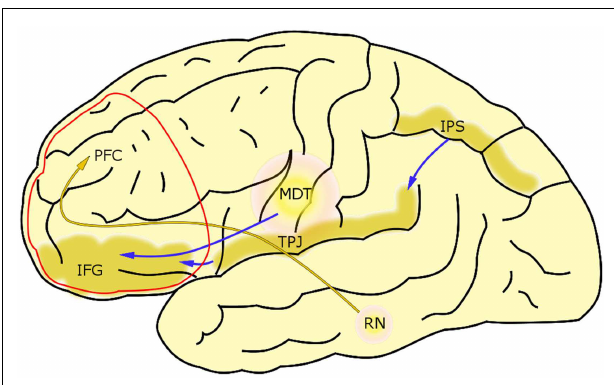
FIGURE 5 |Attention as an example of a construct with multiple neural mechanisms underneath . Maintaining attention can be disrupted by at least two distinct mechanisms: (1) Oversensitivity of the ventral attention network. Imaging studies revealed two systems managing attention in humans. On one hand, we have dorsal attention system, consisting of frontal eye fields (FEF) and intraparietal sulcus (IPS), controlling voluntary deployment of attention (top-down control). On the other hand, we have a right-lateralized ventral attention network (VAN), responsible for orienting attention toward sensory stimuli. It involves temporoparietal junction (TPJ), intraparietal sulcus (IPS) in the parietal cortex, and inferior frontal gyrus (IFG). IFG, as a part of orbitofrontal cortex, receives a strong excitatory input from medial dorsal thalamus (MDT). Since MDT is overactive in MDD, this effect can make ventral attention network oversensitive to stimuli, and as a result holding attention on salient stimuli becomes difficult to the patient. (2) Diminished communication through coherence in the prefrontal cortex. Serotonin produced in the raphe nucleus (RN) modulates gamma oscillations in the prefrontal cortex (PFC), most probably by acting on fast-spiking interneurons expressing serotonin 5-HT 2 and 5-HT 6 receptors. Gamma oscillations play a key role in higher cognitive processes, including attention and working memory. Since serotonergic input to the prefrontal cortex is known to be diminished in MDD, the decrease in gamma power may account for the effect of distractibility in MDD. Both of the above mechanisms lead to a decrease in inhibition within the prefrontal cortex, which might explain why the attention, managed in the PFC, both can be disrupted in a result of hyperactivity of the medial dorsal thalamus and hypoactivity of the raphe